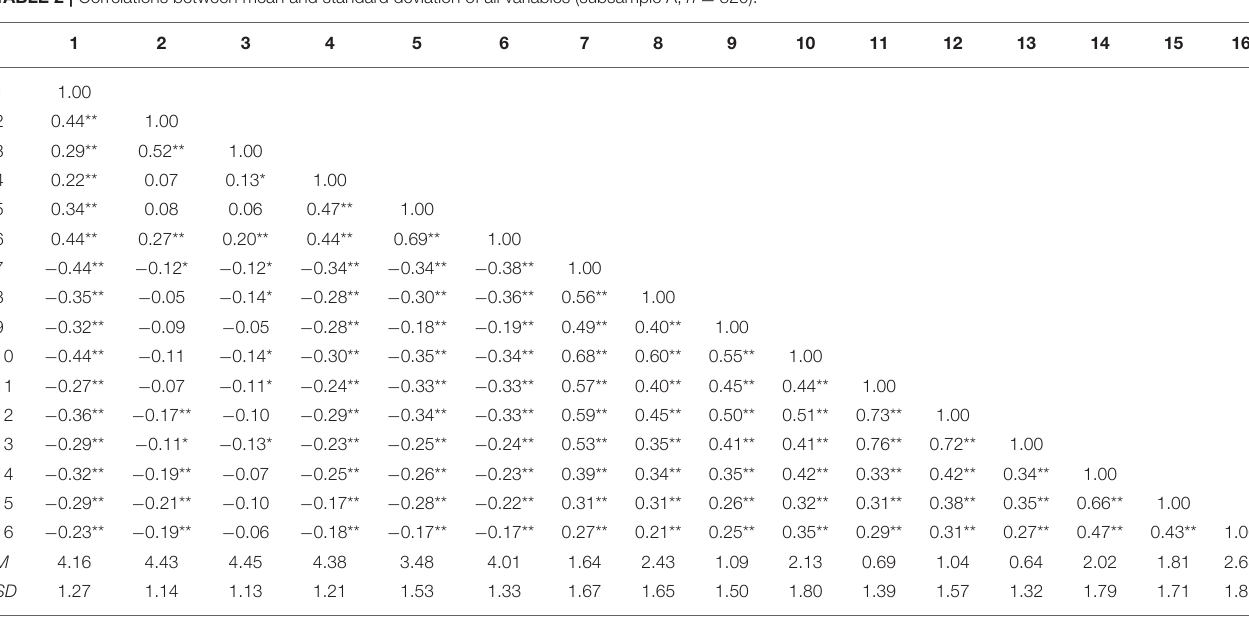
TABLE 2 | Correlations between mean and standard deviation of all variables (subsample A, n =